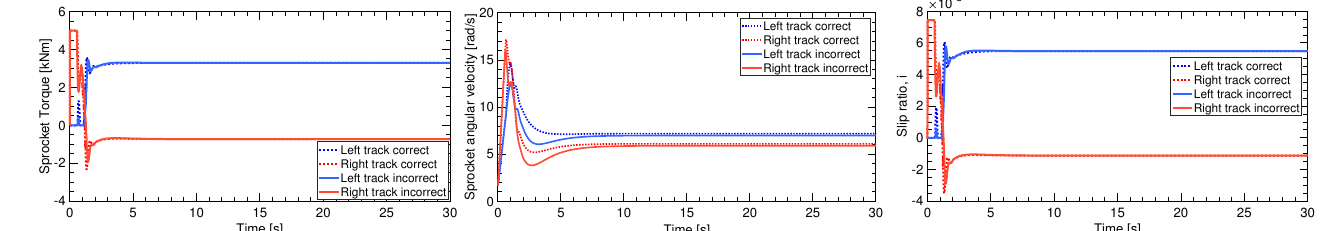
Figure 16. Trajectory following test in case of incorrect knowledge of incorrect mass and inertia: torque behavior ( left ), sprocket rotational velocity ( middle ), slip of the track ( right ).